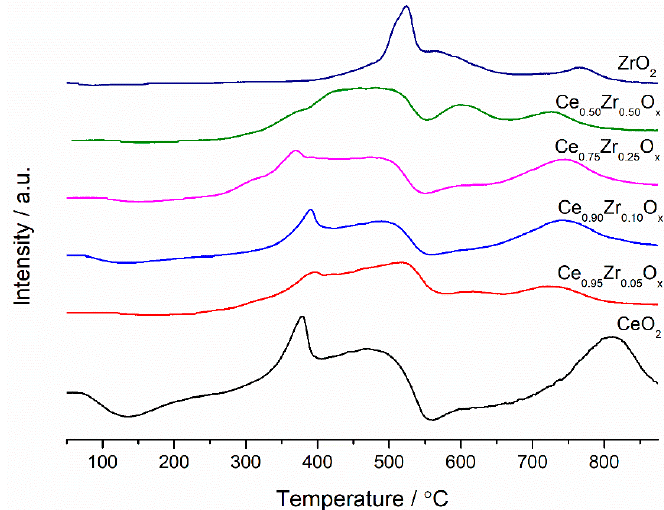
Figure 5. Hydrogen temperature programmed reduction profiles of the ceria–zirconia mixed metal oxide catalysts prepared from carbonate precursors. Analysis conditions: 30 mg sample, 30 ml min -1 of 10% H 2 /Ar, heating rate of 15°C min -1 .